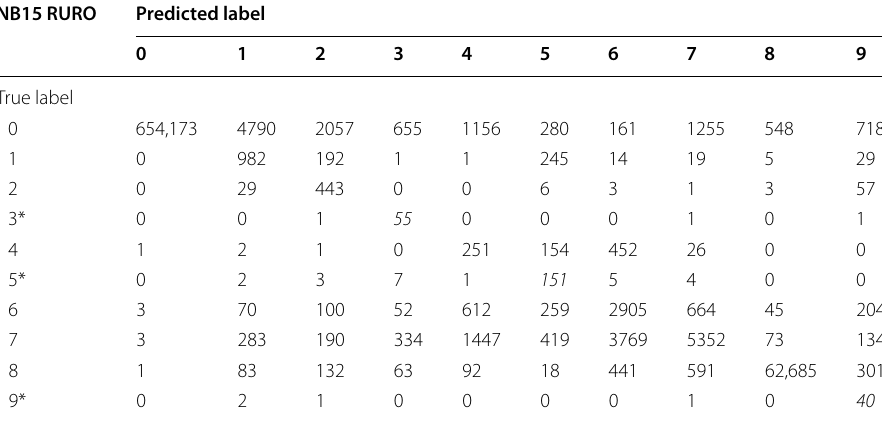
Table 25 Confusion matrix: NB15 RURO NB15 RURO